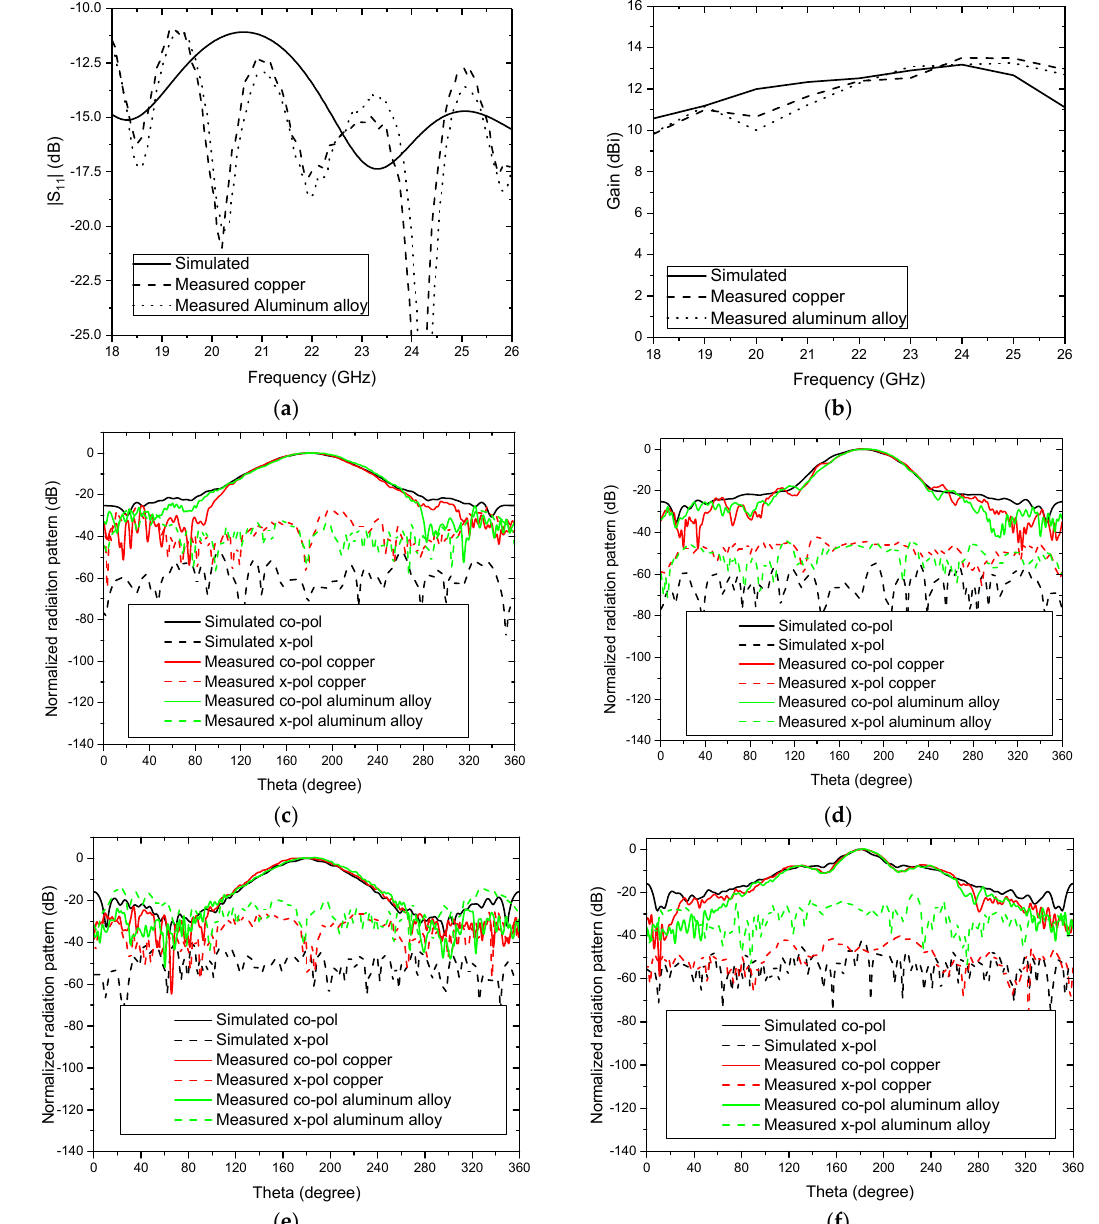
Figure 3. Measured performance of the 3D-printed, K-band-stepped, double-ridged square horns: ( a ) |S 11 |; ( b ) gain; ( c ) radiation patterns on phi = 0° @ 18 GHz; ( d ) radiation patterns on phi = 90° @ 18 GHz; ( e ) radiaiton patterns on phi = 0° @ 26 GHz; ( f ) radiation patterns on phi = 90° @26 GHz.